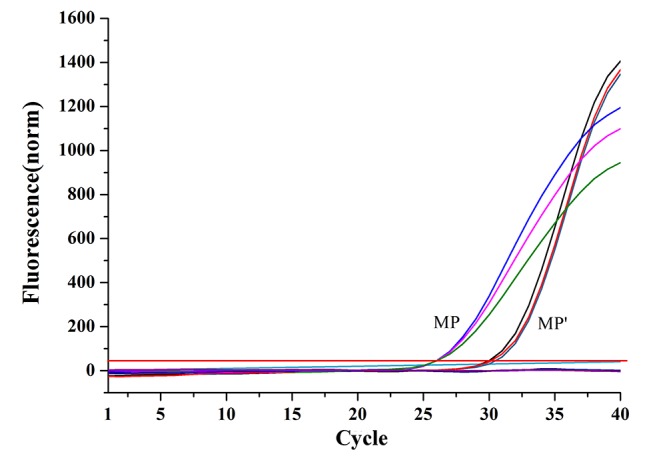
Comparison of the capture capabilities of two magnetic capture probes based on qPCR assays (MP: magnetic capture probe prepared using Method 1; MP′: magnetic capture probe prepared using Method 2).